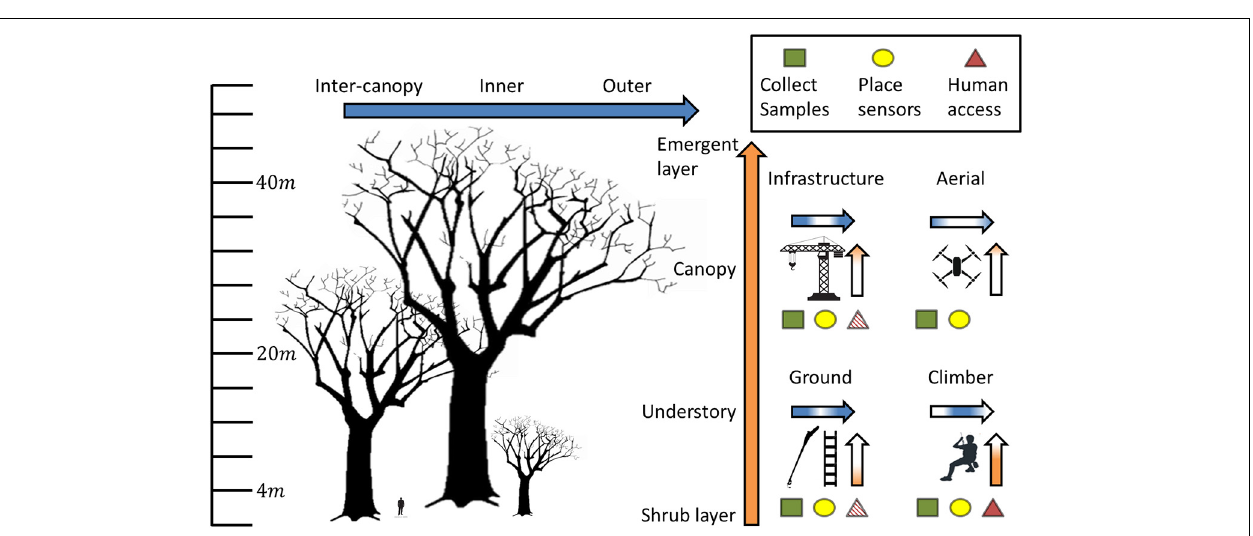
FIGURE 7 | The relative ability of each of the predominant methods of tree canopy access to obtain a sample, given the sample’s position in the tree canopy. The blue shading indicates the horizontal accessibility, from the spaces between tree crowns, the inner crown and the outer crown, left to right. The orange shading indicates the vertical accessibility, from the ground to the emergent portion of the canopy. Shading on horizontal and vertical arrows indicates current access, given each method: darker indicated better access. The modes of sample collection are also shown: instantaneous (collecting a sample) by a square; continuous (place a sensor) by an ellipse; and direct human action by a triangle. Darker shading indicates the overall accessibility by that particular